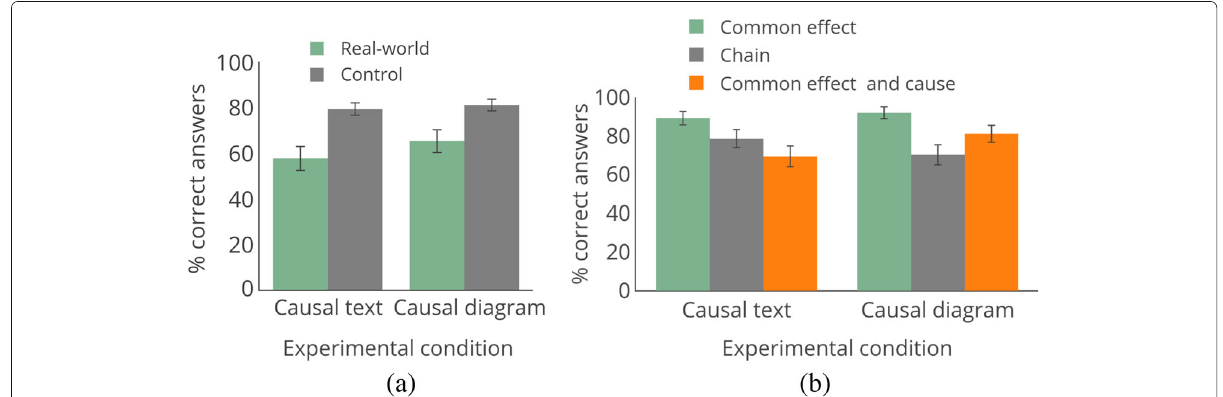
Fig. 7 Experiment 4 results, focusing on control vs. real-world questions. Error bars show 95% confidence interval. a Comparing real-world and control questions. b Individual control